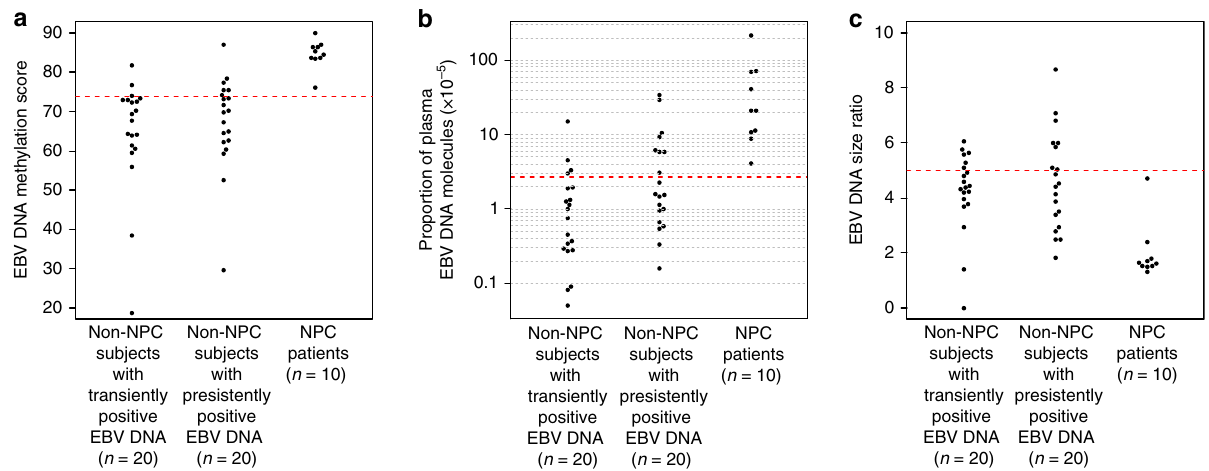
Fig. 3 Methylation-, count- and size-based analyses of plasma EBV DNA in the exploratory sample set. a The EBV DNA methylation scores of the NPC patients and non-NPC subjects with transiently positive and persistently positive results are shown. A cutoff value in the EBV DNA methylation score was de fi ned at 3 standard deviations below the mean of the methylation scores of these 10 NPC patients in the exploratory dataset. The cutoff value of 73.7 is denoted by the red dotted line. b The proportion of EBV DNA reads among the total number of sequenced plasma DNA reads (both human and viral) of the NPC patients and non-NPC subjects with transiently positive and persistently positive results are shown. A cutoff value in the proportion of plasma EBV DNA reads was de fi ned at 3 standard deviations below the mean of the logarithmic values of portion of EBV DNA reads of the 10 NPC patients in the exploratory dataset. The cutoff value of 2.7 × 10 − 5 is denoted by the red dotted line. c The EBV DNA size ratios of the NPC patients and non-NPC subjects with transiently positive and persistently positive results are shown. A cutoff value was de fi ned at 3 standard deviations above the mean values of the EBV size ratios of all the 10 NPC patients in the exploratory dataset. The cutoff value of 5.0 is denoted by the red dotted line. Source data are provided as a